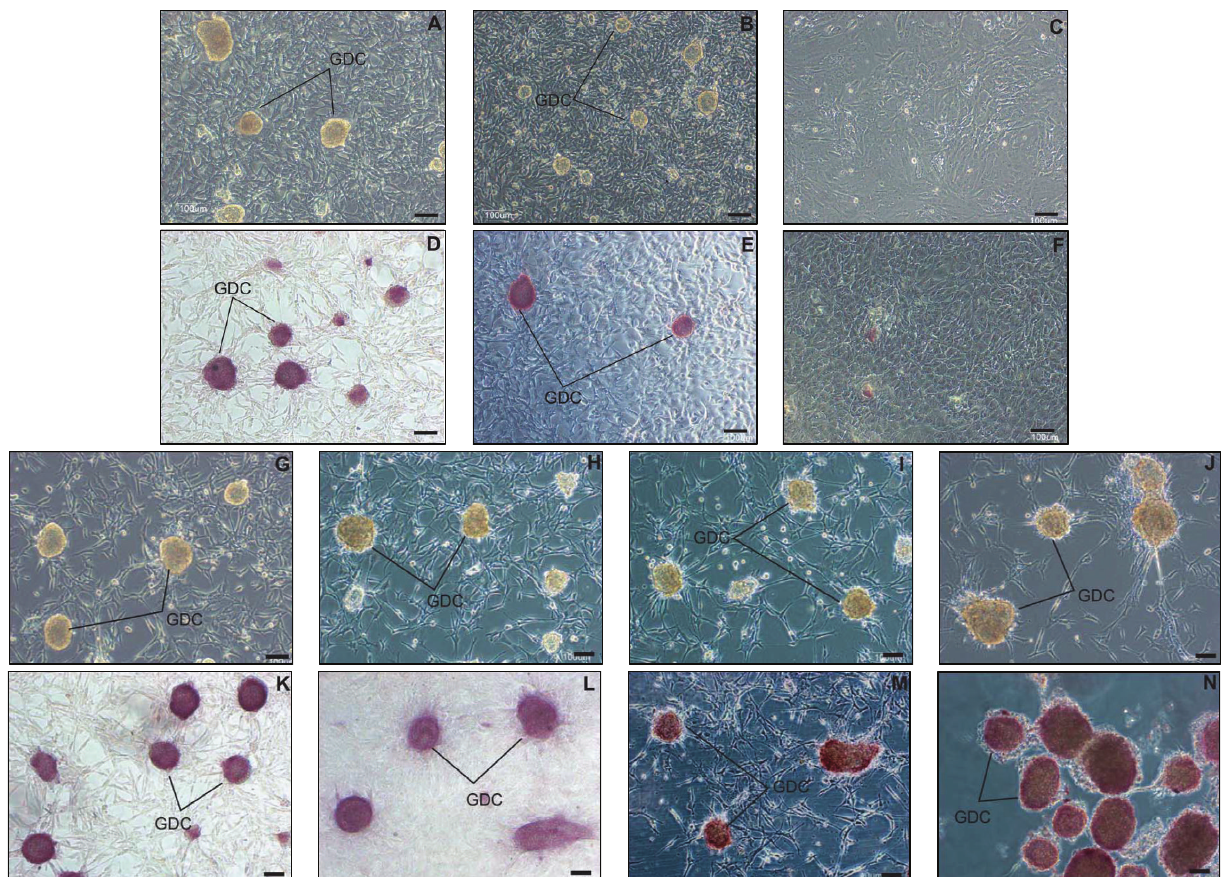
Figure 2: Long-term culture using old and fresh feeder cells. Old feeder cells (OFCs), which were attached to the wells in passages 0 and 1 after colony collection on days 10 to 12, were used for subculture in passages 1 and 2 with the collected colonies at passages 0 and 1, respectively ((A), (B), and (C)). Fresh feeder cells (FFCs), isolated from the top of the 40% Percoll layer during density separation of total testicular cells, were used for subculture of colonies of passages 1 to 7. GDCs in passages 2, 4, 8, and 13 are shown in panels (G), (H), (I), and (J), respectively. Alkaline phosphatase-stained colonies in passages 0, 1, and 2 areshown in panels (D),(E), and (F), respectively. Alkaline phosphatease-stained GDCs in passages 2, 4, 8, and 13 are shown in panels (K), (L), (M), and (N), respectively. Scale bars indicate 100 𝜇 m in all panels. GDC: germ cell-derived